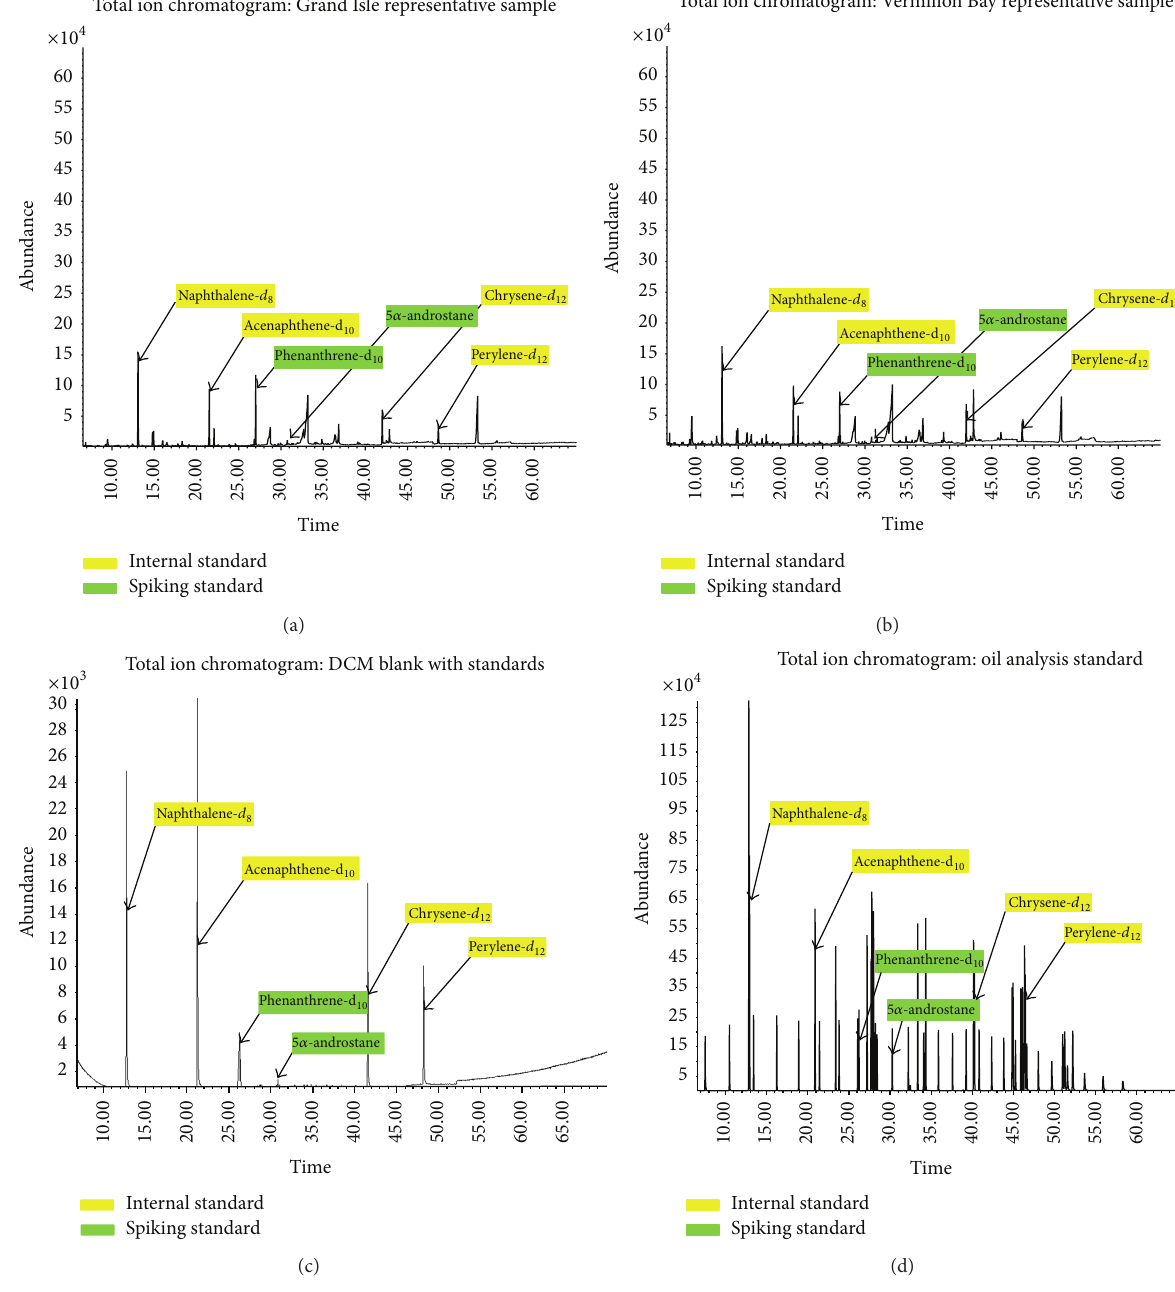
Figure 5: Total ion chromatograms of (a) representative Grand Isle sample, (b) representative Vermilion Bay sample, (c) method blank, and (d) oil analysis calibration standard @ 5.0